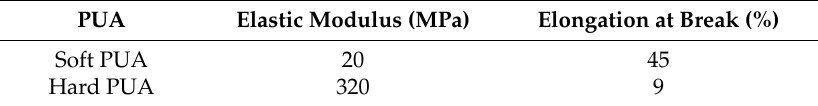
Figure 3. ( a ) Measured interlocking adhesion strengths of the interlocked soft polyurethane acrylate (PUA) and hard PUA microstructures with different tip thicknesses of 5 µ m and 9 µ m; ( b ) Repeatability and durability of the interlocking hard PUA adhesive with a 9 µ m-tip; ( c ) Optical microscope images of the microstructure array before and after the repeatability tests. Table 1. Mechanical properties of soft and hard PUA